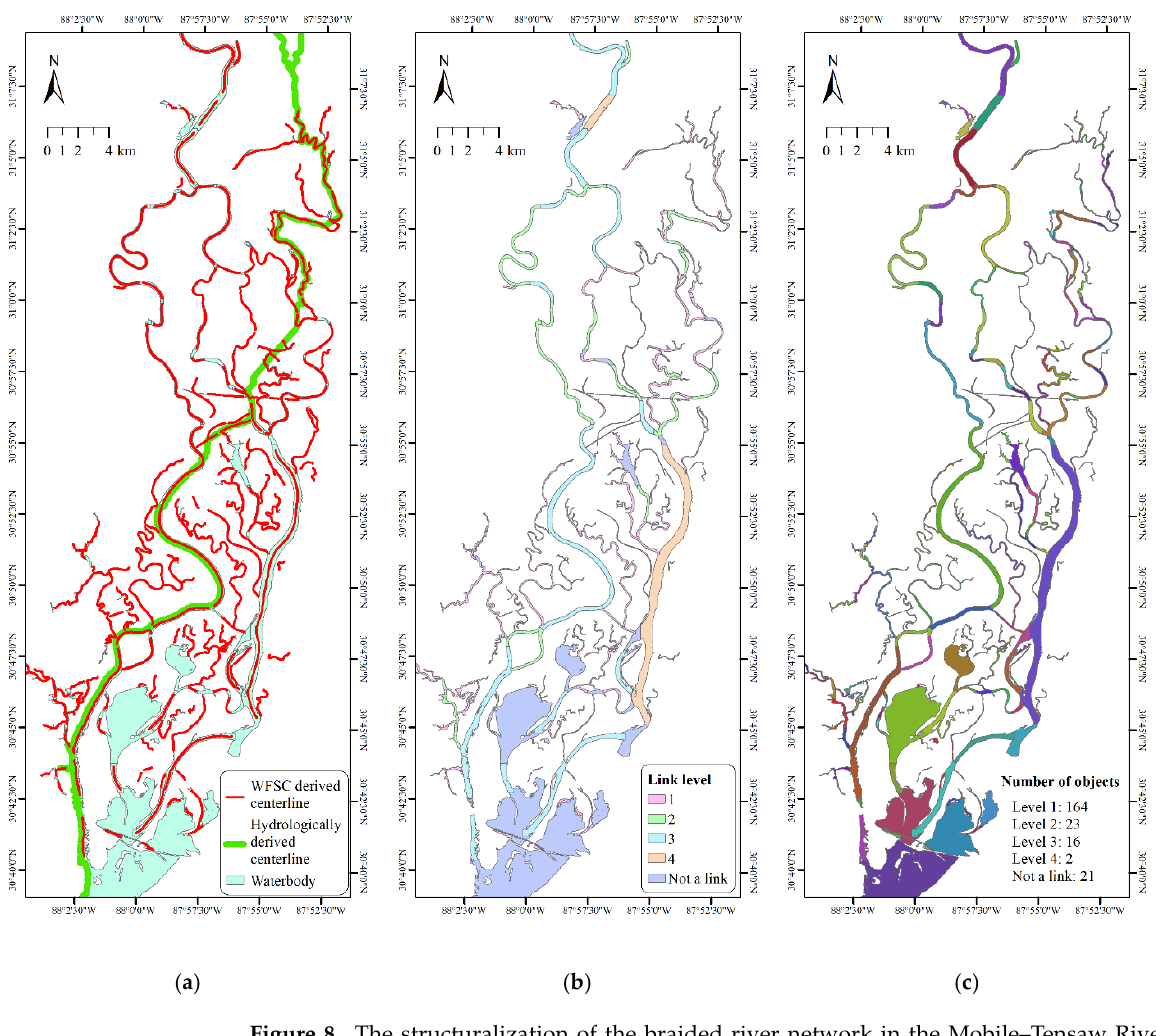
Figure 8. The structuralization of the braided river network in the Mobile–Tensaw River Delta (Figure 1 c ) using a multi-level scheme. The single lotic habitat image object has been properly structuralized into 205 river links on 4 levels and 21 non-link waterbodies.